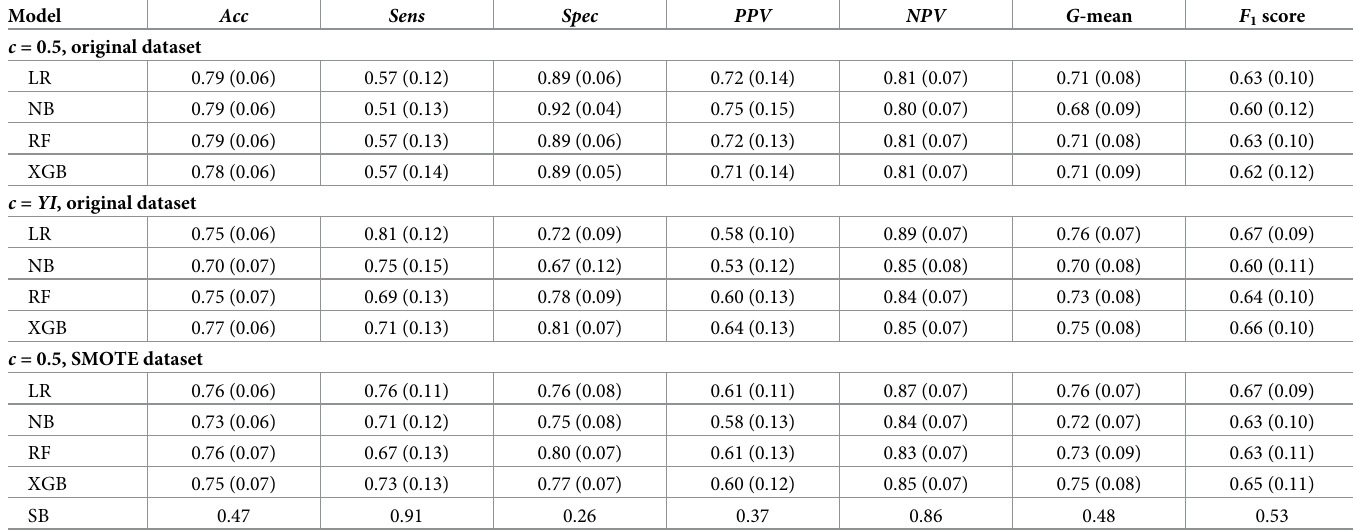
Table 4. Mean and standard deviation values of operating characteristics (OC), for different classification algorithms and techniques to cope with data imbalance, and values obtained with SB criteria.